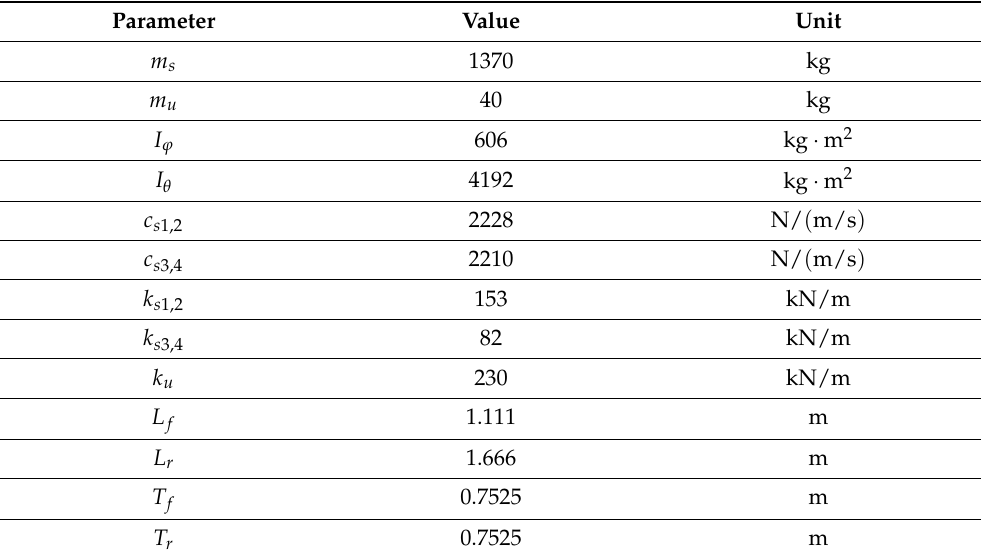
Table 1. Parameters related to 7-DOF vehicles.